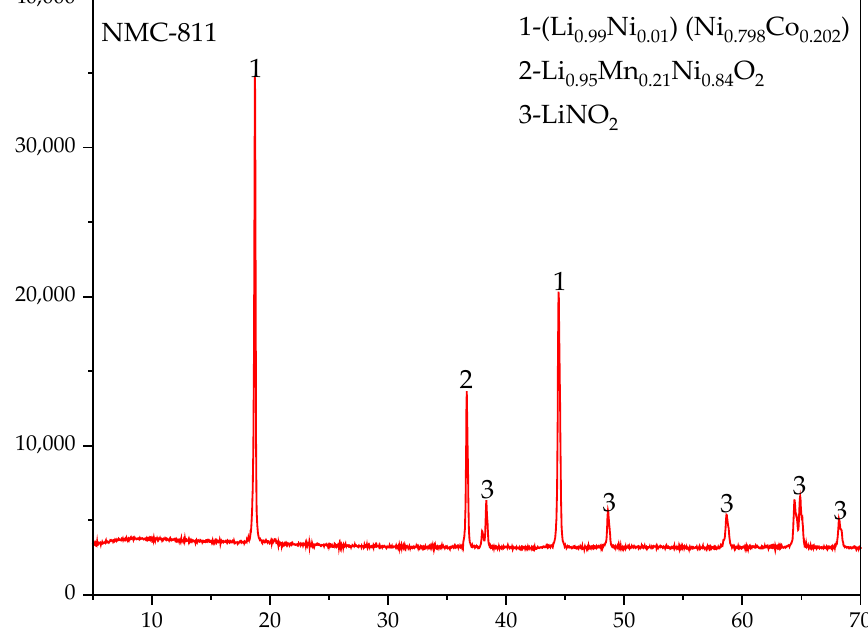
Figure 1. XRD pattern of the waste NMC-8111 ternary lithium battery.